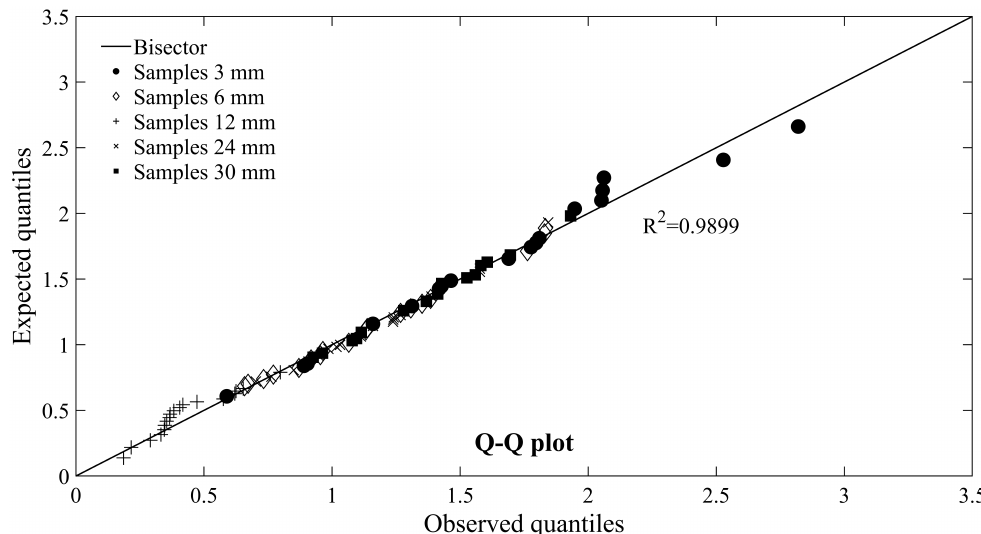
Figure 3. Q-Q plot for the normalised VHCF life.